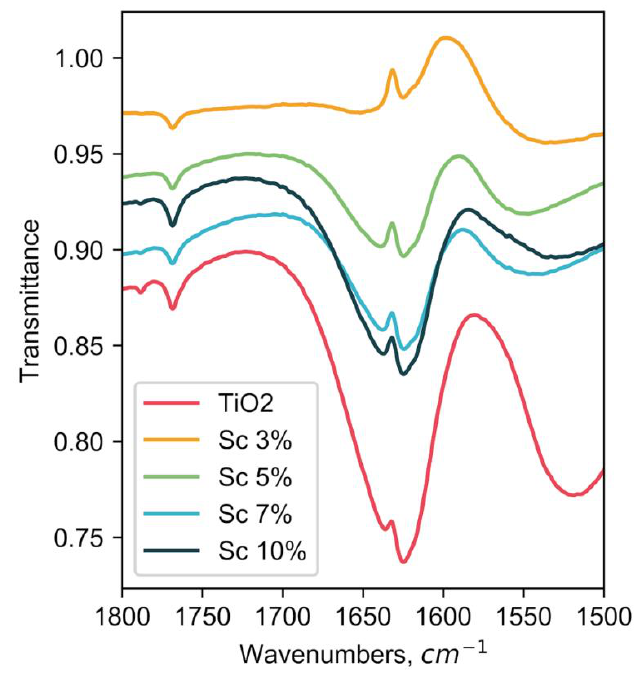
Figure A5. IR spectra of synthesized samples.